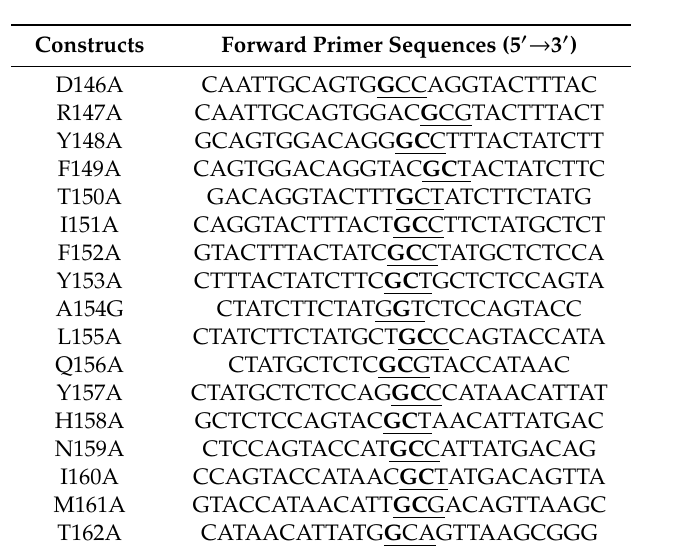
Table 2. Forward primer sequences used for site-directed mutagenesis studies of human MC4R. The mutated codons are underlined and the mutated nucleotides are in